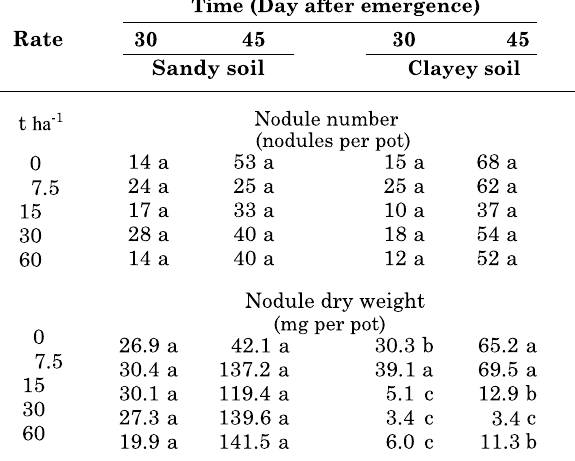
Table 5. Changes in nodule number (nodules per pot) and nodule dry weight (mg per pot) of cowpea growing in soils amended with composted tannery sludge